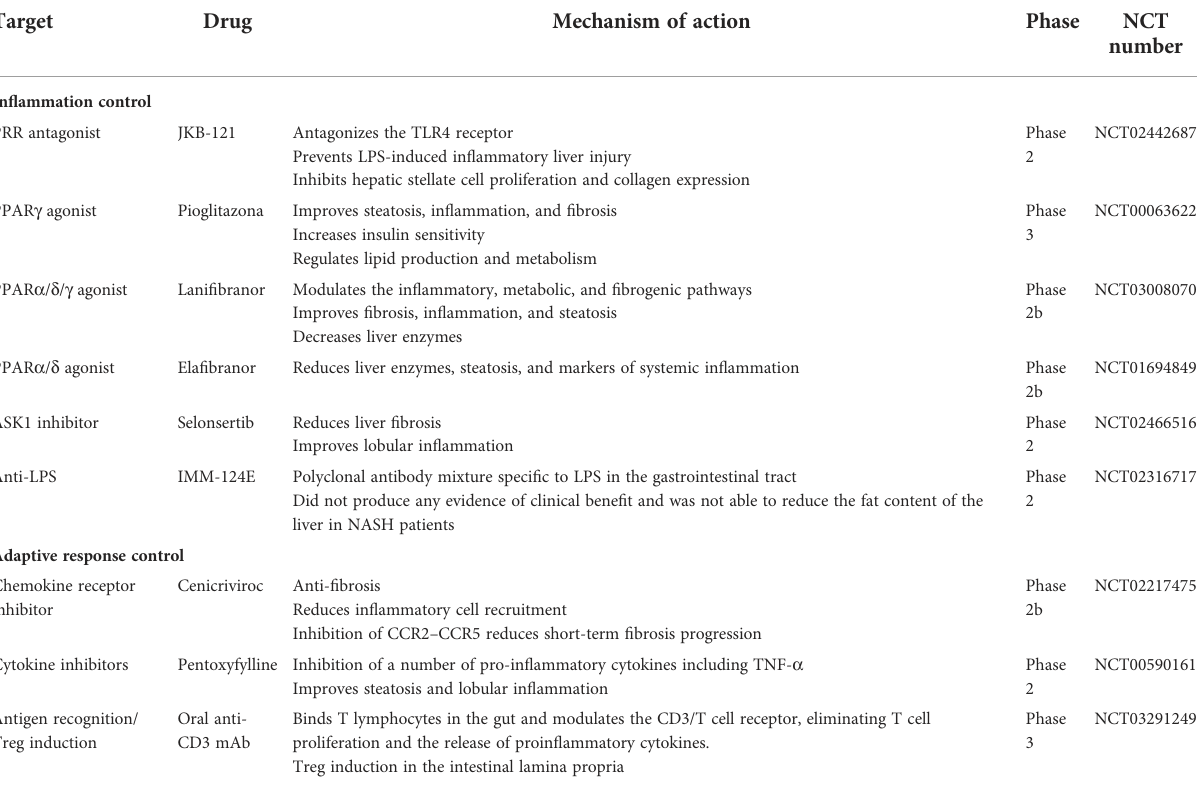
TABLE 1 Clinical trials of pharmacological approaches targeting the immune response in NAFLD.